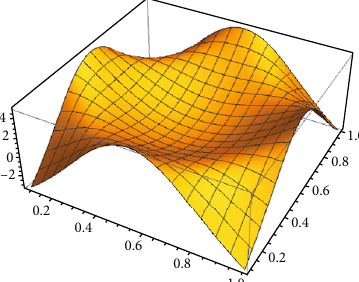
Figure 3: The mean curvature function of the biquadratic Bézier surface with shifted knots for η = 0 : 2 and λ = 0 : 2